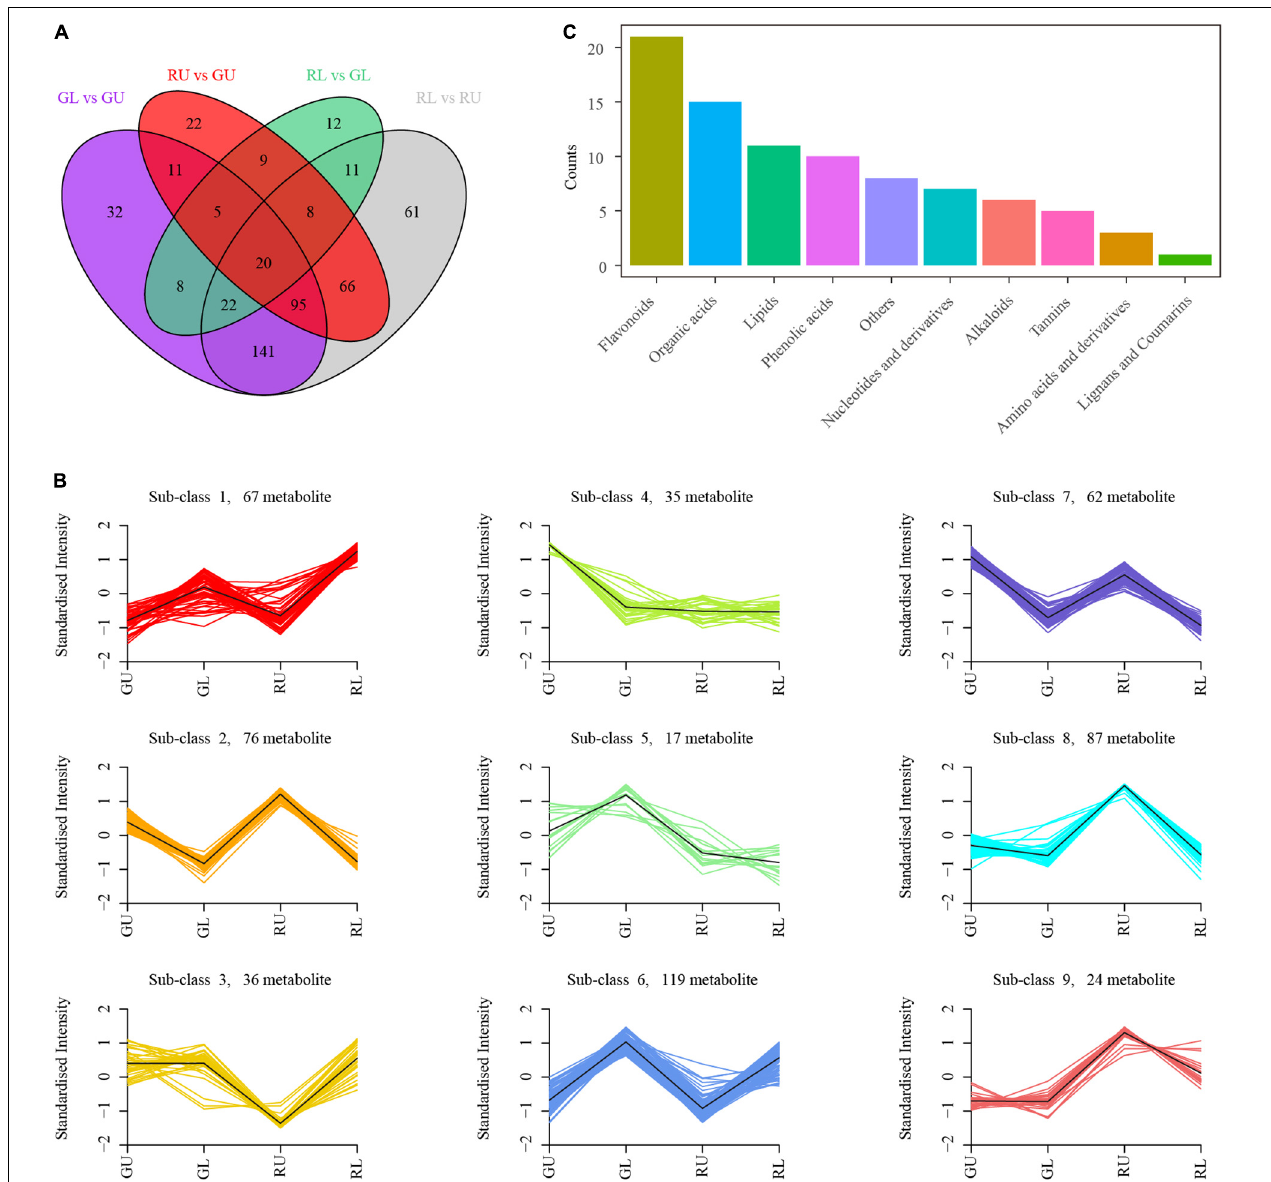
FIGURE 3 | DAMs in H. hainanensis . (A) Venn diagram of DAMs from all comparisons. (B) k-means clustering analysis of total differential metabolites. (C) DAMs abundance by type in subclass